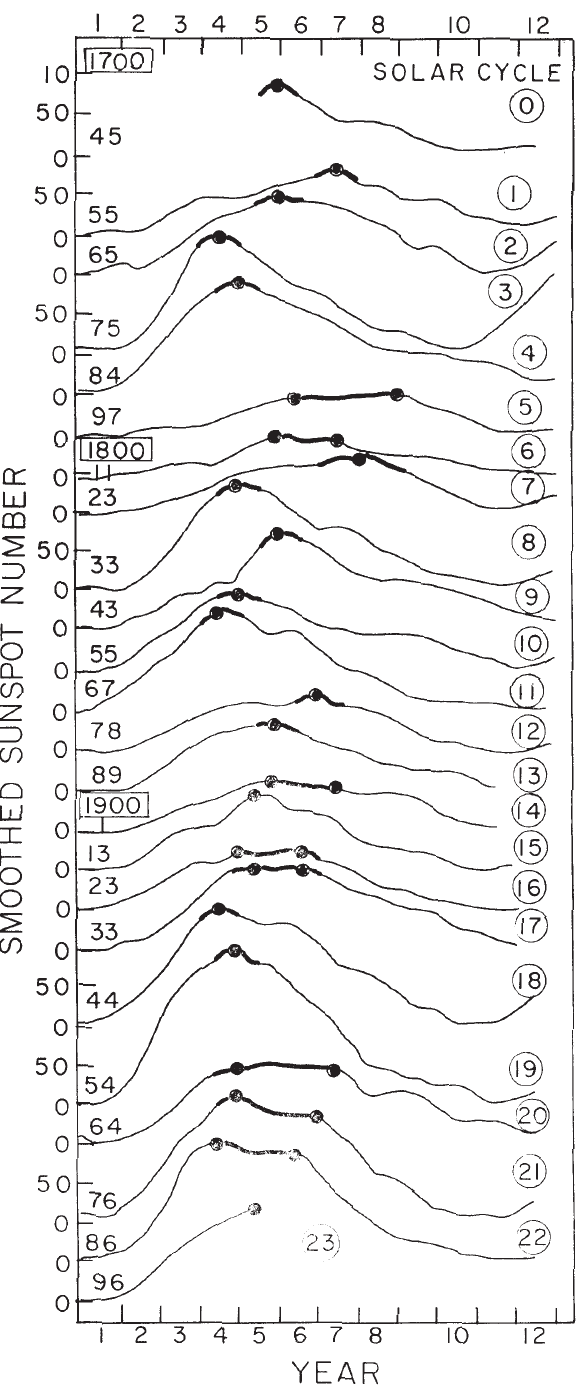
Fig. 1. Plot of smoothed monthly sunspot numbers for cycles 0–23. The full dots indicate